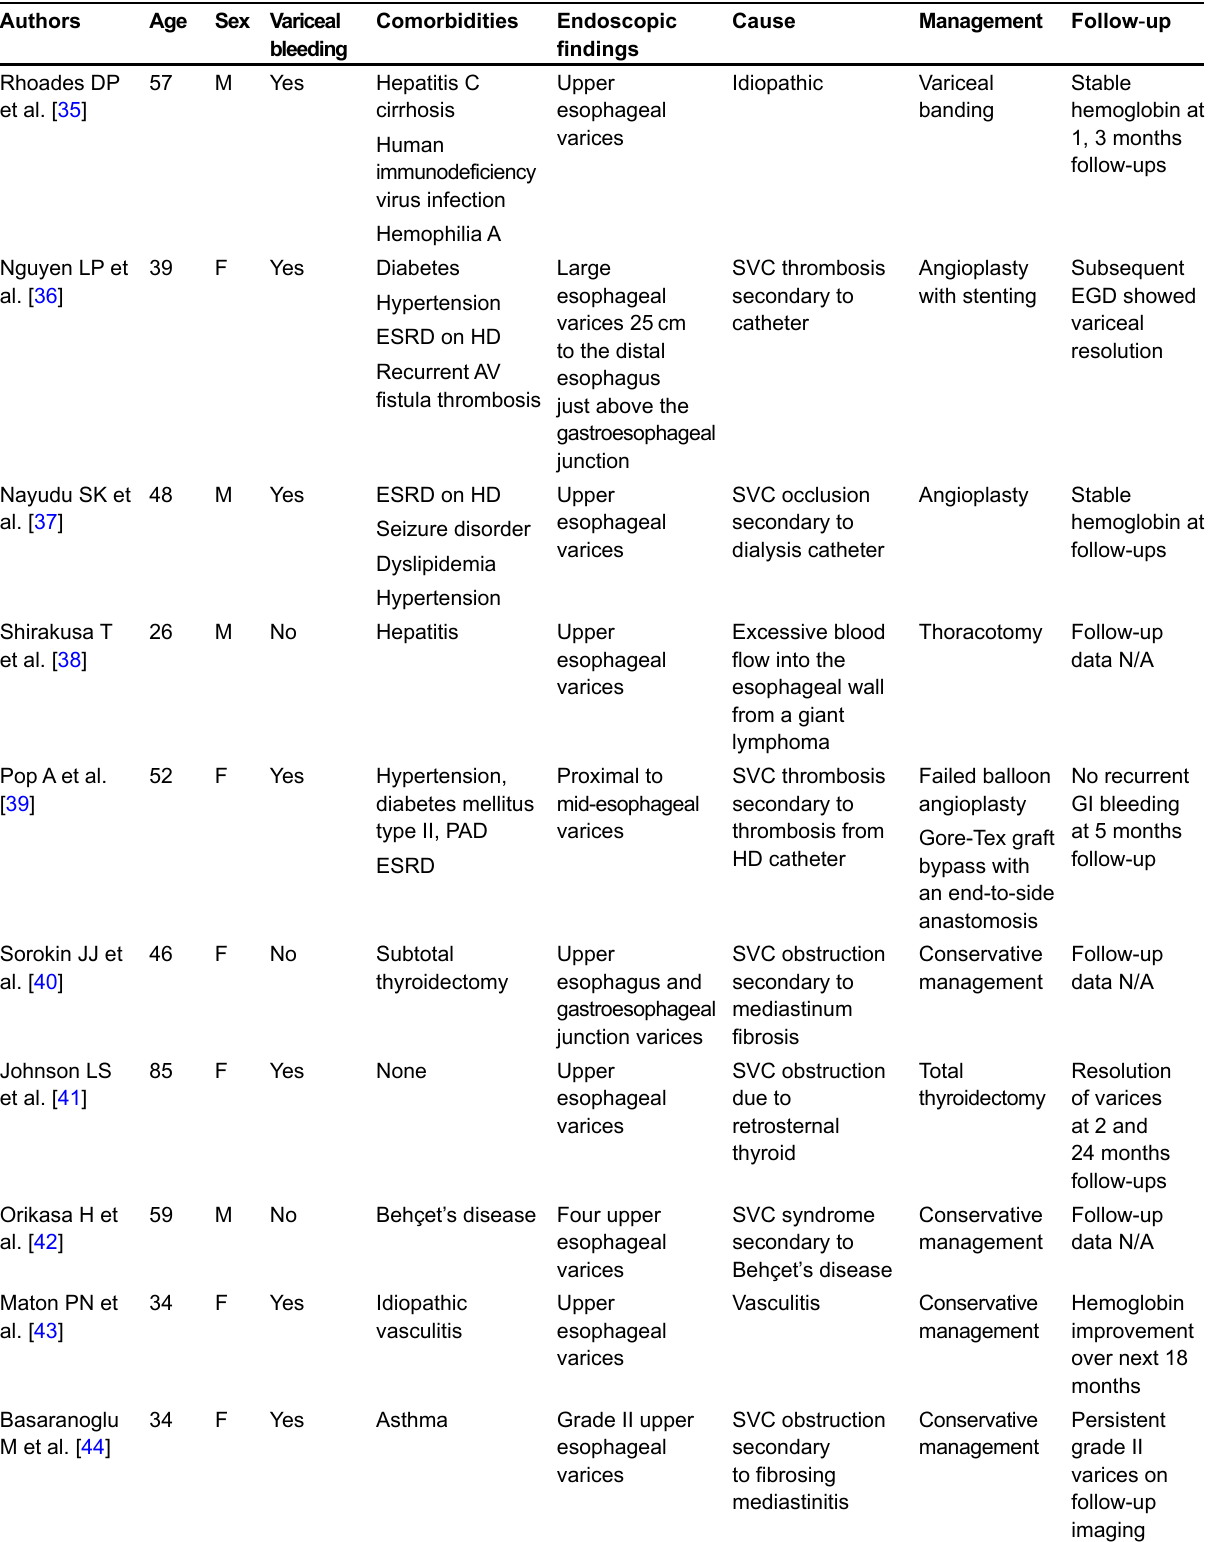
Table 1. Demographics, presentation, causes and management of patients with downhill varices ( continued